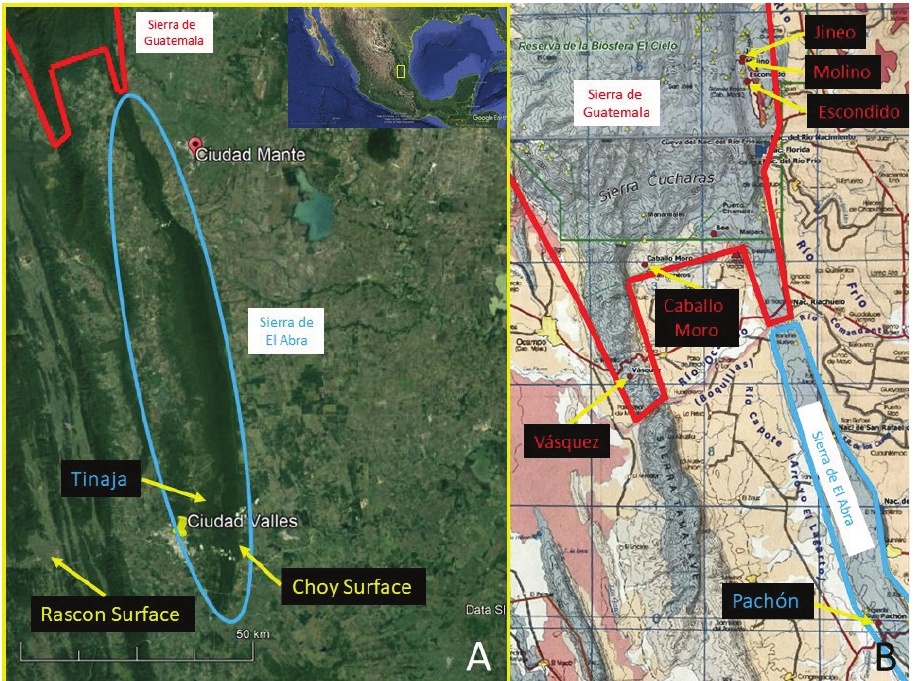
Figure 1. Localities of cave populations A satellite photo of Sierra de Guatemala (Red) and Sierra de El Abra (Blue). Inset shows the area of México. Map data 2021 (C) Google B topographic map modified from Elliot (2018). Sierra de Guatemala caves are shown in red while Sierra de El Abra caves in